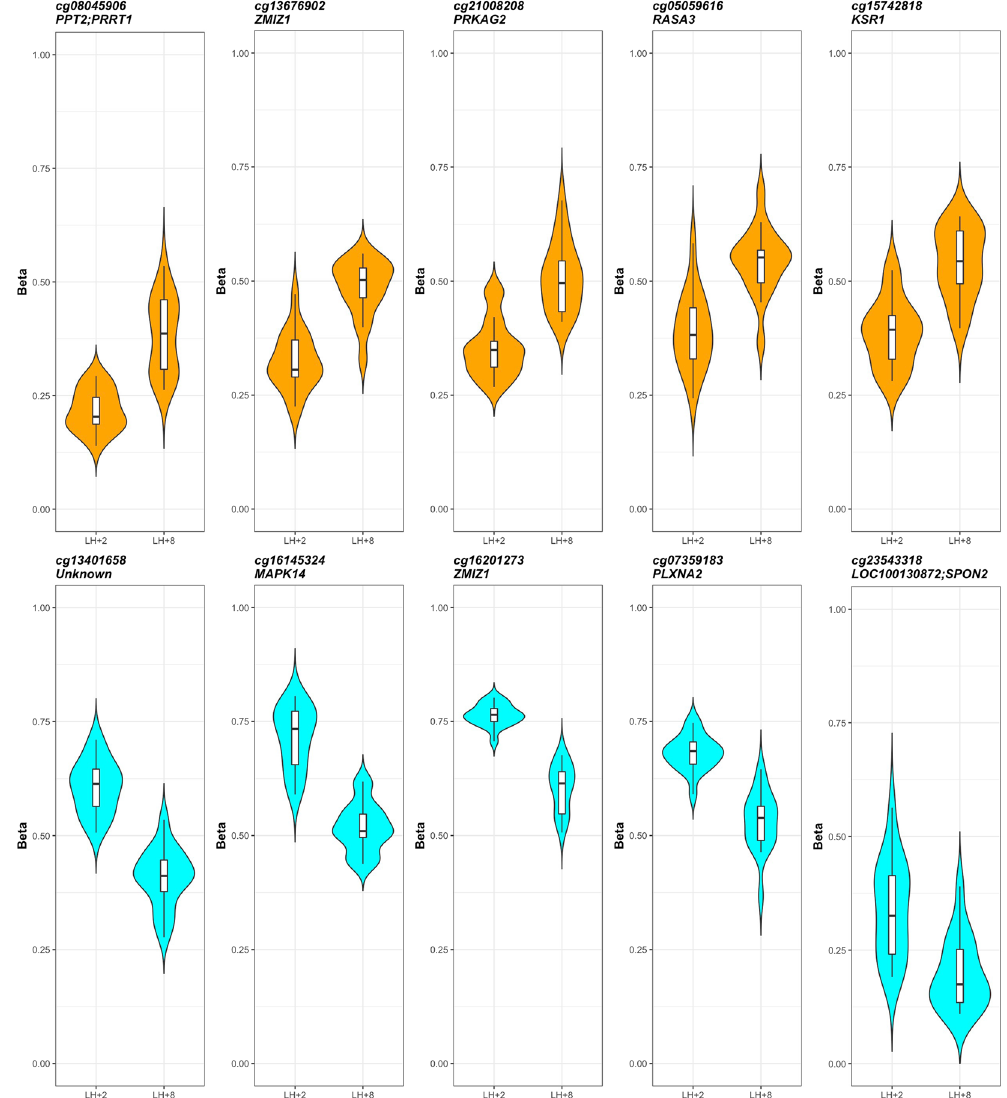
Figure 3. CpG-level differential methylation analysis results. Methylation levels of top 10 CpG sites differentially methylated between pre-receptive and receptive endometrium. Each plot represents a single CpG site and the gene it was annotated to. Upper panel (orange) – higher methylation in receptive endometrium; lower panel (light blue) – lower methylation in receptive